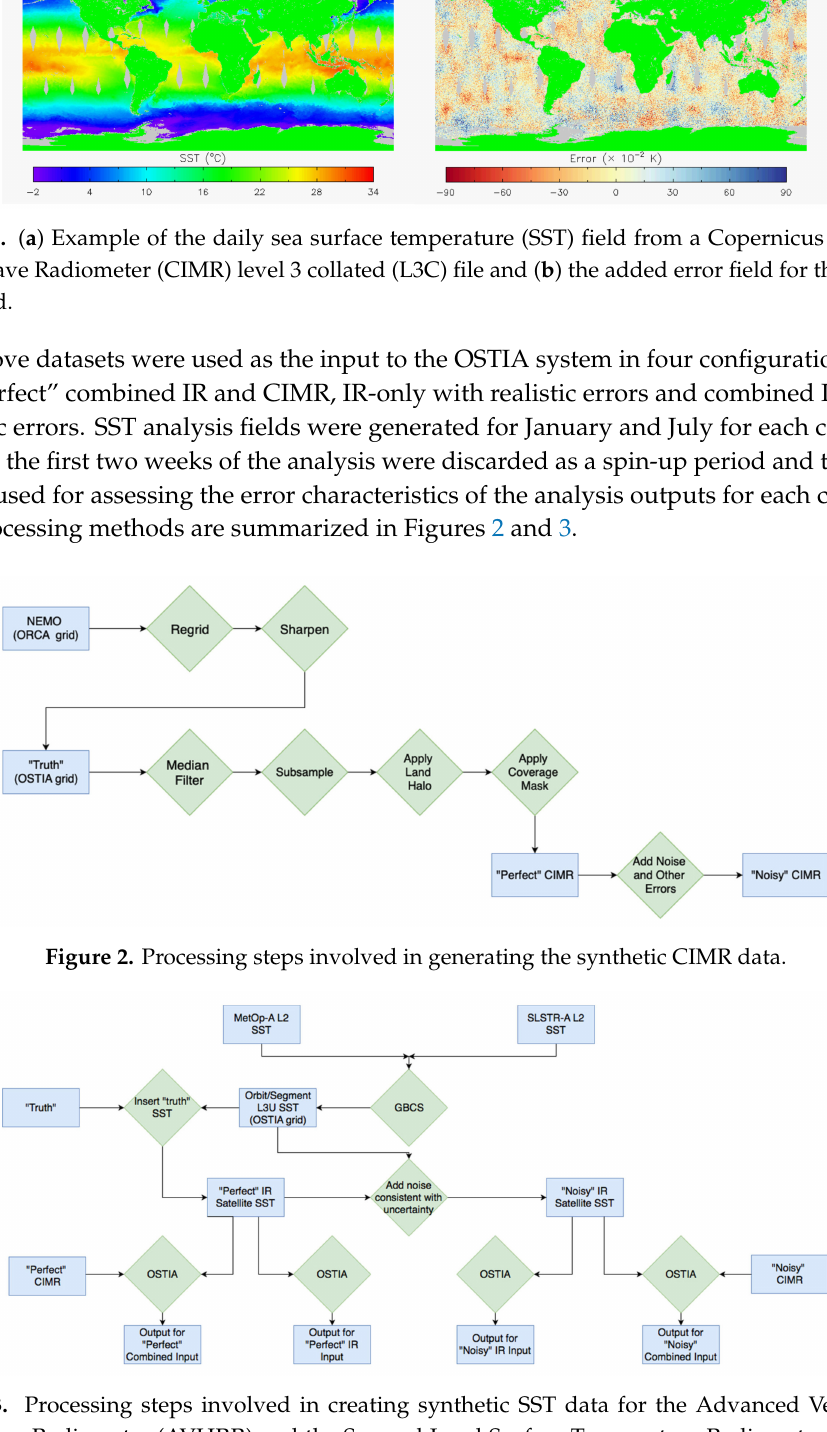
Figure 3. Processing steps involved in creating synthetic SST data for the Advanced Very High Resolution Radiometer (AVHRR) and the Sea and Land Surface Temperature Radiometer (SLSTR). The data generation made use of the Generalised Bayesian Cloud Screening (GBCS) processor and the Operational Sea Surface Temperature and Sea Ice Analysis (OSTIA)